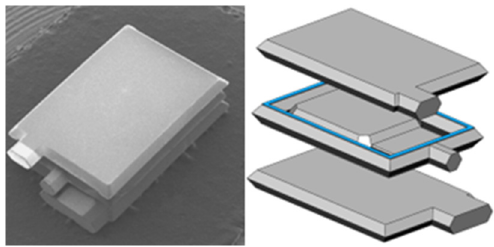
Figure 6. Physical drawing of the closed-loop accelerometer.